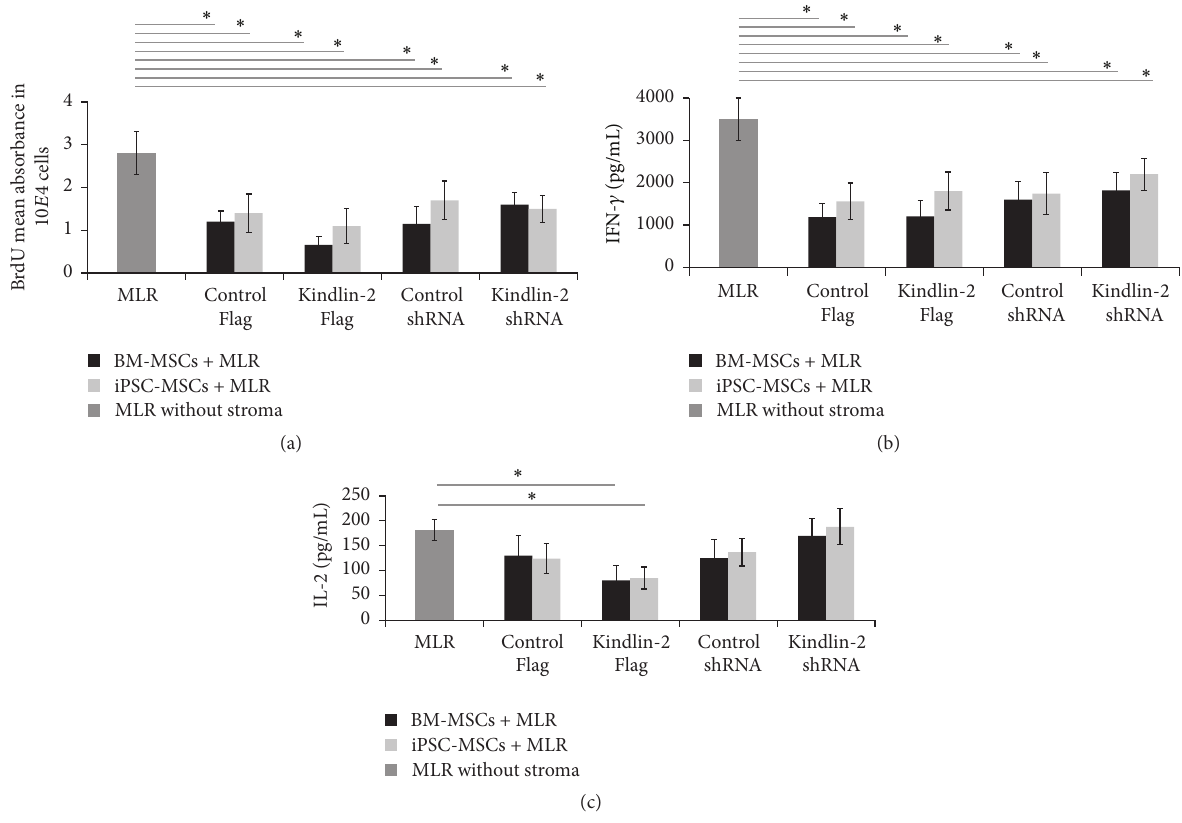
Figure 7: iPSC-MSCs suppress inflammatory reaction after transfection with Kindlin-2. To investigate the immunomodulatory properties of iPSC-MSCs after Kindlin-2 overexpression/knockdown, mixed lymphocyte reaction (MLR) was used to mimic an inflammatory reaction by mixing CD4 + lymphocytes with healthy donor peripheral blood mononuclear cells (PMNCs) on iPSC-MSCs or BM-MSCs feeder layers. (a) CD4 + lymphocyte proliferation in an MLR assay using BrdU incorporation. The iPSC-MSCs/BM-MSCs could significantly ( 𝑝 ≤ 0.05 ) decrease lymphocyte proliferation in all four groups compared to MLR without a feeder layer. No significant differences were found between the different MSC groups (not indicated). (b and c) Production of cytokines IFN- 𝛾 and IL-2 in the supernatant of MLR assays from the iPSC- MSC/BM-MSCs coculture experiments. A significant decrease of IFN- 𝛾 levels was observed between controls without MSCs and iPSC-MSC or BM-MSCs coculture experiments in all four groups, but no significant differences were noted between MSC groups (b). Compared to MLC without MSCs, IL-2 significantly decreased only in the Kindlin-2 overexpression group and not in other groups compared to MLR without a feeder (c). ∗ Significance difference 𝑝 ≤ 0.05